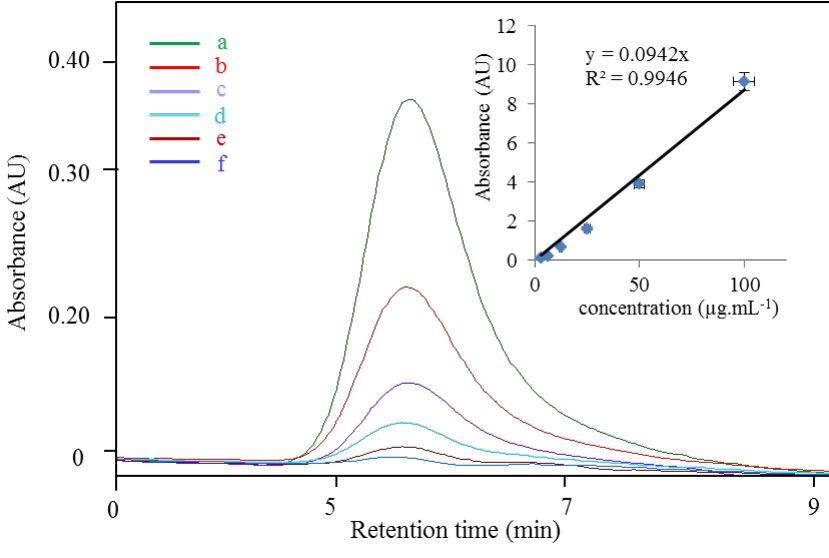
Figure 2. Calibration curve of PC2 in IEC: (a) 100, (b) 50, (c) 25, (d) 12.25, (e) 6 and (f) 3 µg·mL −1 PC2 in H2O. The experimental conditions were as follows: